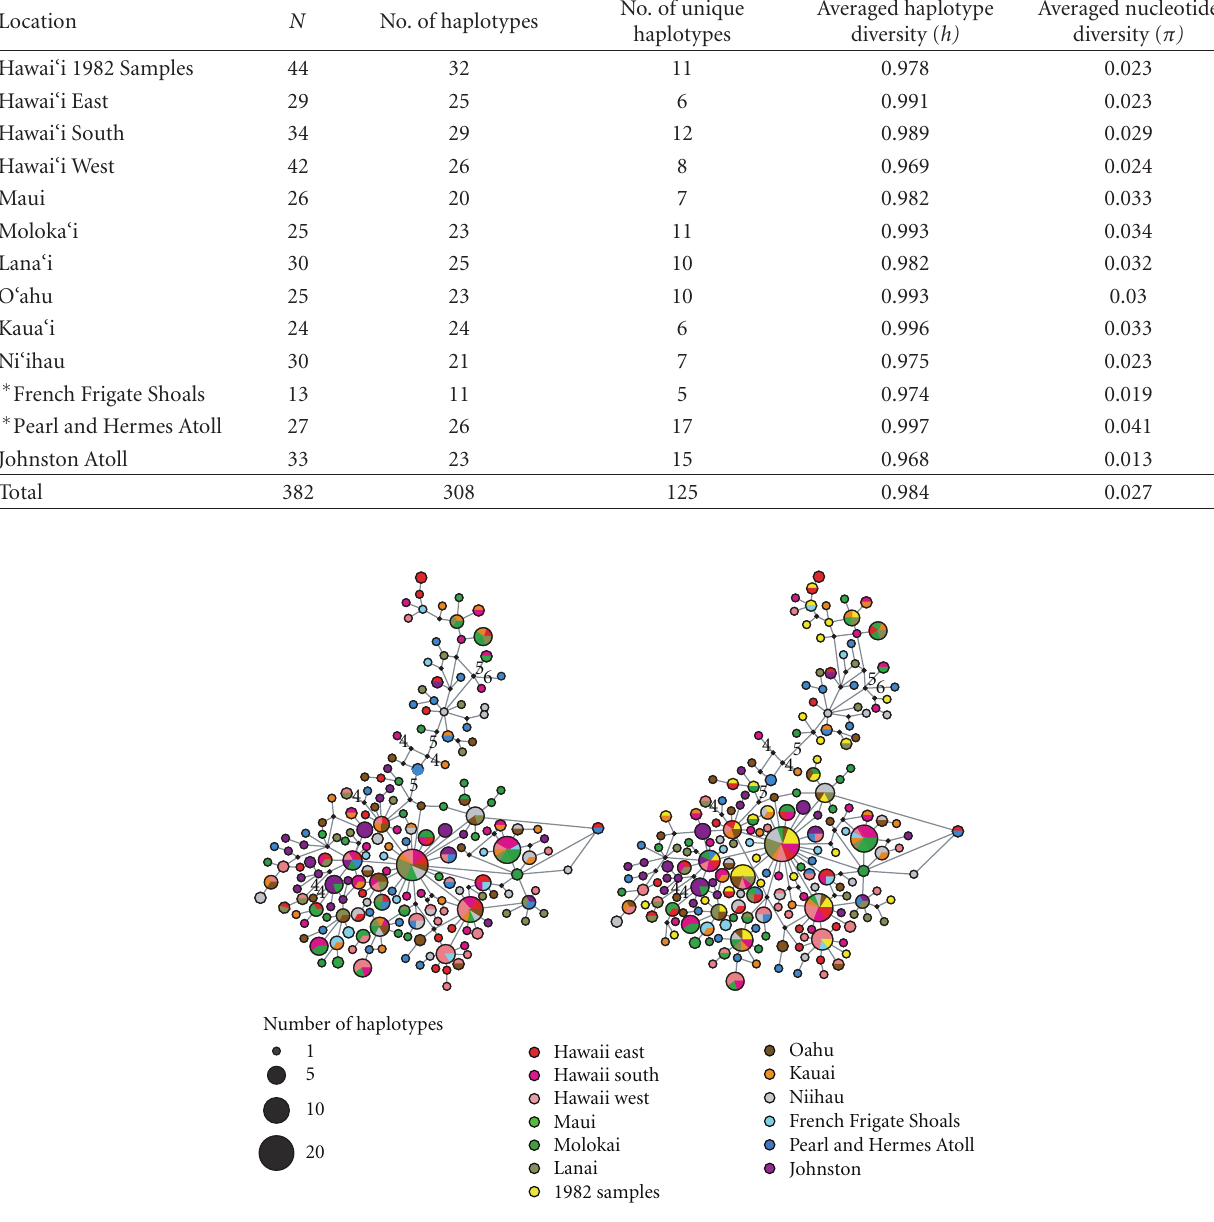
Figure 2: Median joining haplotype network of Acanthaster planci samples from Johnston Atoll and the Hawaiian Archipelago. The network to the right includes the samples from 1982 and the network to the left does not. Each circle represents a unique haplotype connected by a line to those that di ff er by one or more base pairs. Those lines that represent > 4bp di ff erences were labeled, but lines are not to scale. Nodes on the lines indicate missing haplotypes. Each haplotype is color coded by region and size of the pie chart is proportional to frequency. The smallest colored circles represent a singleton haplotype and the largest circle represents 20 individuals who share that